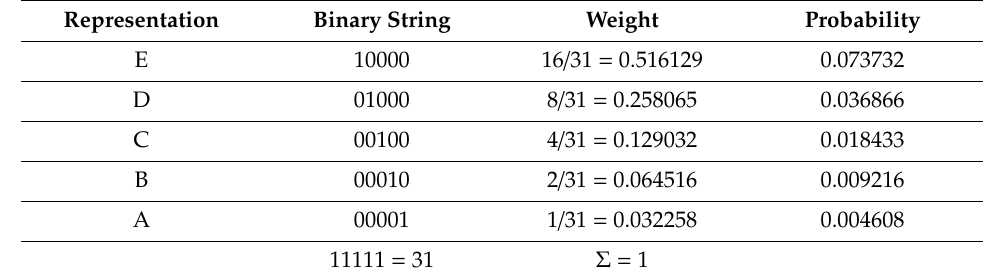
Table 2. Binary representation of risk levels.